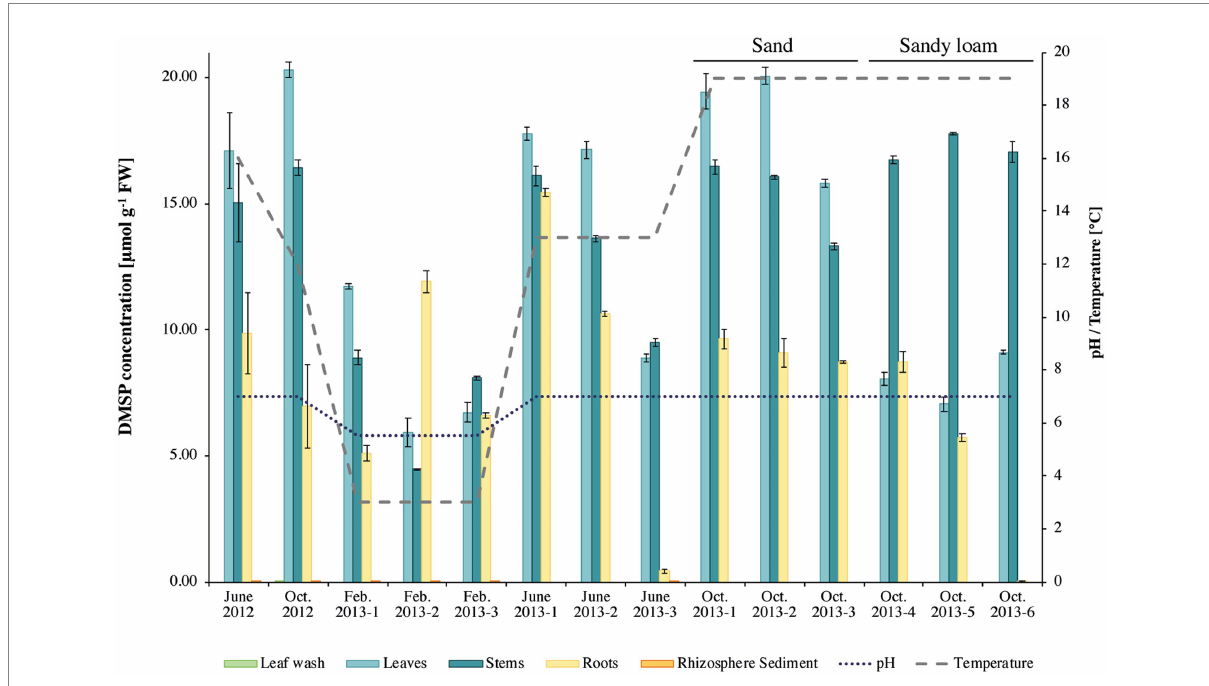
FIGURE 1 Dimethylsulfoniopropionate (DMSP) concentrations in Sporobolus anglicus tissue samples. DMSP concentration is given in μ mol g –1 fresh weight of plant material for phyllosphere (leaf wash, leaf, and stem) and rhizosphere (root and sediment) samples of Sporobolus anglicus over an annual cycle (June 2012, October 2012, February 2013, June 2013, and October 2013). DMSP concentrations were normalized to 1 g of fresh plant material. pH and temperature at the sampling site were measured and are shown on the secondary y -axis. Replicate plants samples in